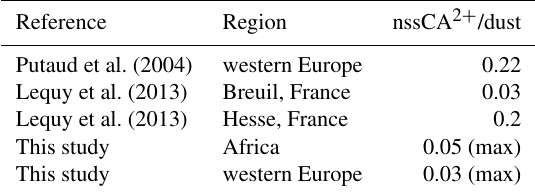
Table 8. Values of the ratio nssCA 2 + / dust found in the literature and modelled in this study. The values correspond to the inverted value of what is generally calculated. Reference Region nssCA 2 + /dust Putaud et al.